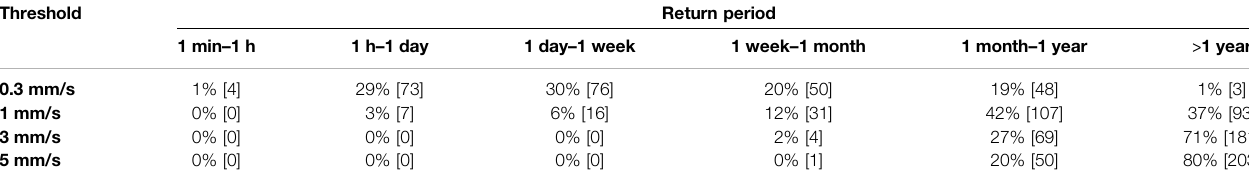
(lower) and 75th (upper) quartile are indicated with striped red lines and the lower and upper envelope with dotted red